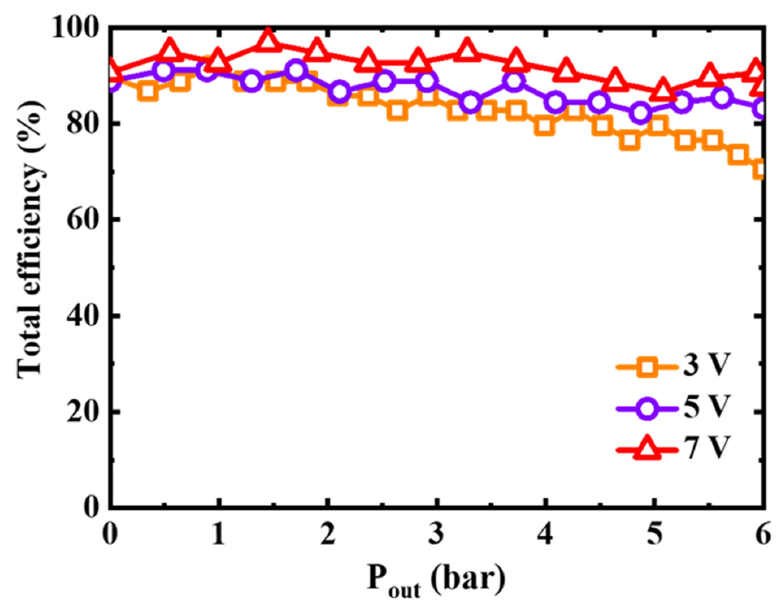
Figure 11. Compression efficiency when the anode pressure was 1 bar and the applied voltage was 3, 5, and 7 V.